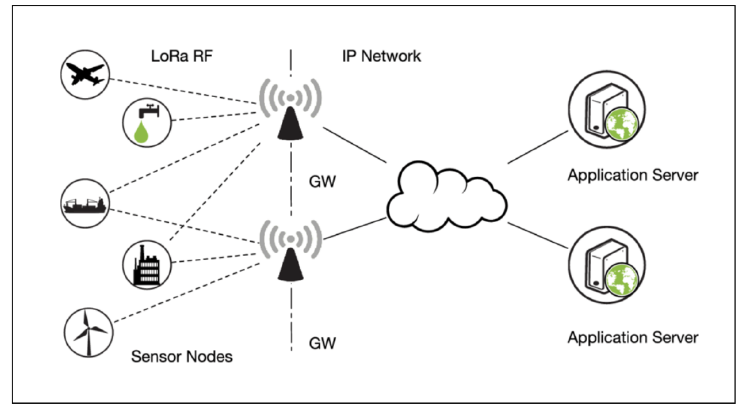
Figure 1. General architecture of LoRaWAN